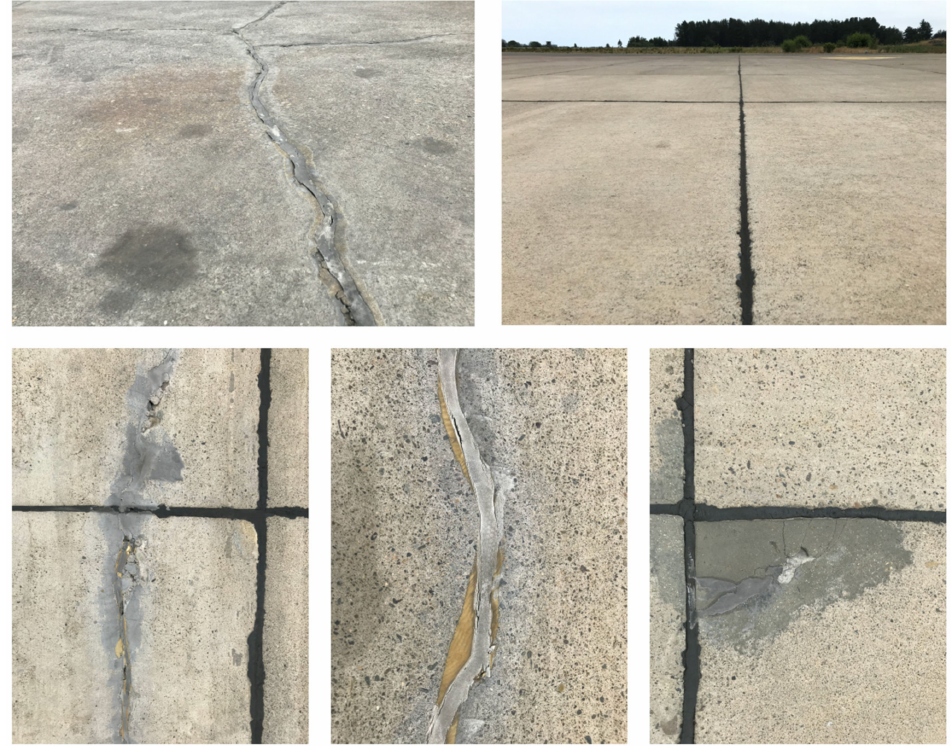
Figure 10. Deteriorations identified in concrete pavements of Military Platforms (Viña del Mar Airport) during data collection of pavement performance via in-situ visual inspections and automatic inspections via Aerial Unmanned Vehicles (UAVs) or